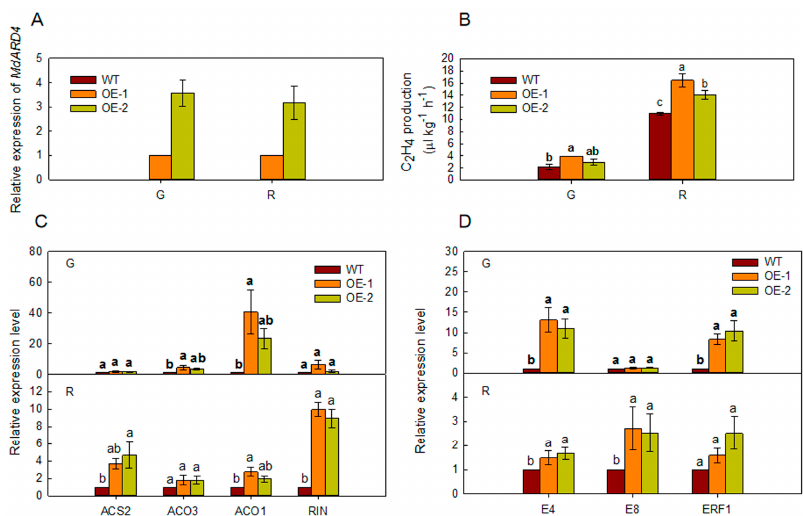
Figure 4. ( A ) Relative expression level of ARD4 from WT and MdARD4 transgenic tomato fruits, the expression level of MdARD4 in line OE-1 was set as 1 and ( B ) ethylene release level of ARD4 from WT and MdARD4 transgenic tomato fruits. Expression of ethylene biosynthesis genes ( C ) and ethylene-responsive genes ( D ) in fruits from WT and MdARD4 transgenic tomato plants. Expression levels were calculated relative to that of CAC , the expression level of each gene in line WT was set as 1. Bars represent the mean value ± SE ( n ≥ 3). Data are means of three replicates with SD. Different letters indicate significant differences between WT and transgenic plants on the same day of different treatments, according to one-way ANOVA Tukey’s multiple range tests ( p < 0.05).